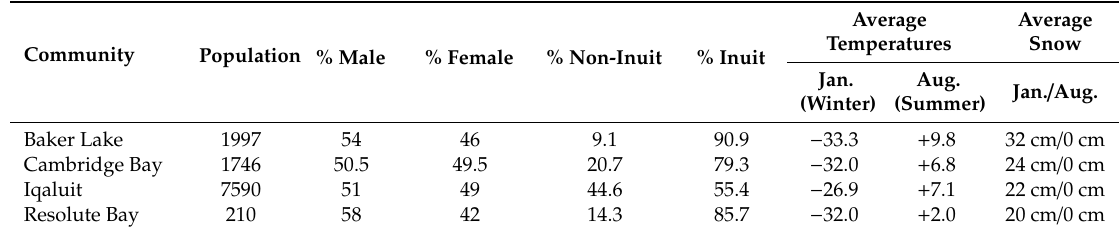
Table 1. Demographic and environmental characteristics of the four participating communities.